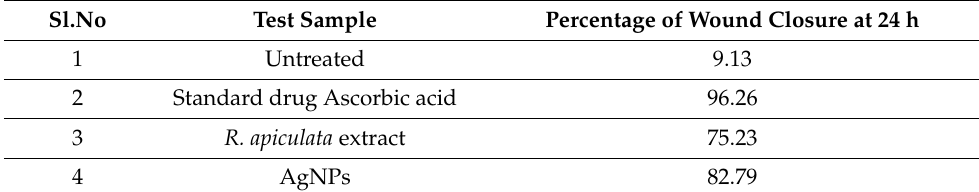
Table 10. Percentage of wound closure of different test samples.